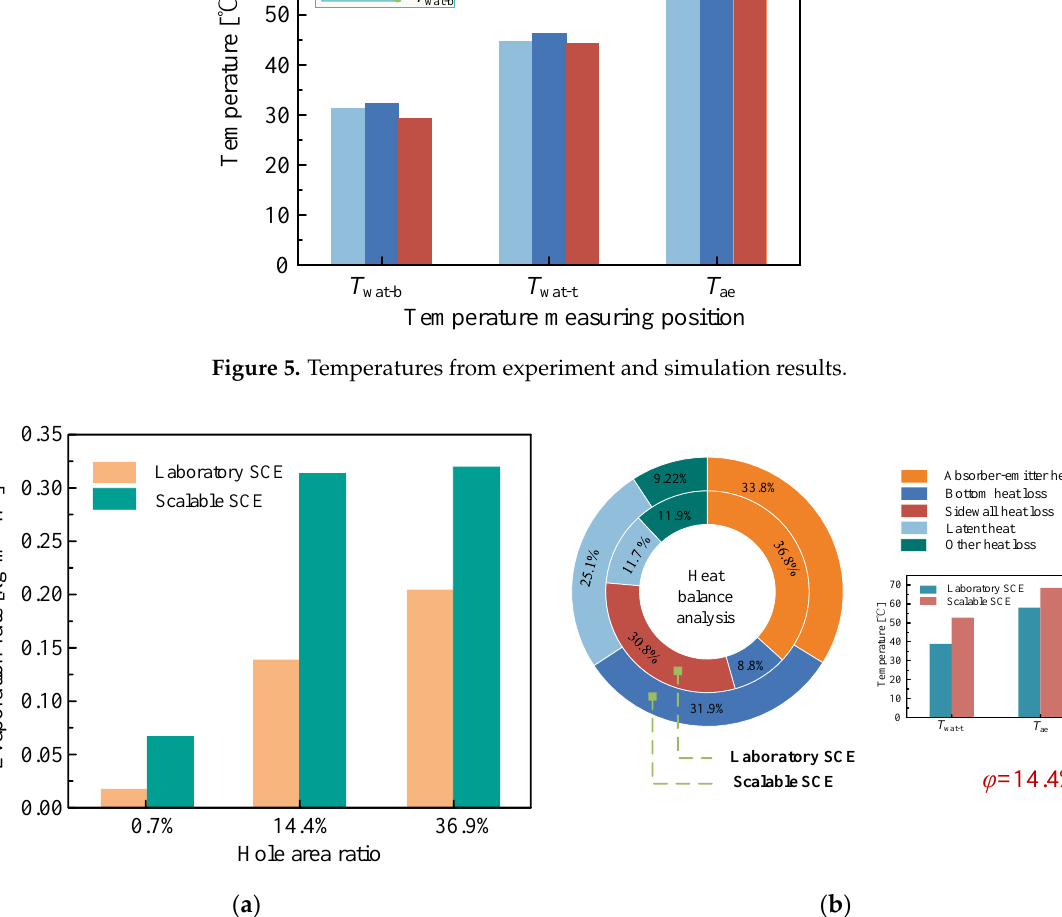
Figure 6. Comparison between laboratory and scalable SCE. ( a ) Evaporation rates of SCE under different hole area ratios (0.7%, 14.4% and 36.9%). ( b ) Heat-balance analysis and key temperatures comparison of two SCE processes under a hole area ratio of 14.4%.